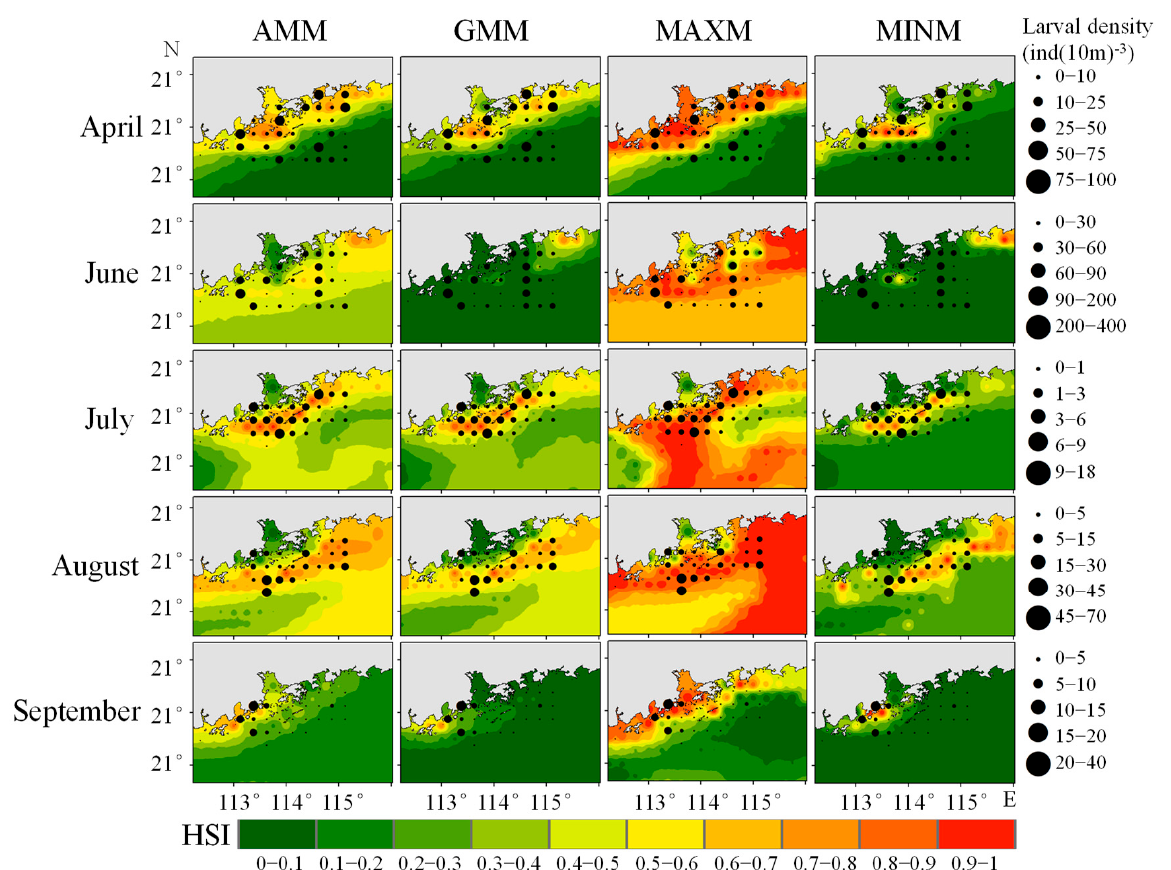
Figure 3. Spatial–temporal distribution of HSI predictions and actual larval density in the PRE.